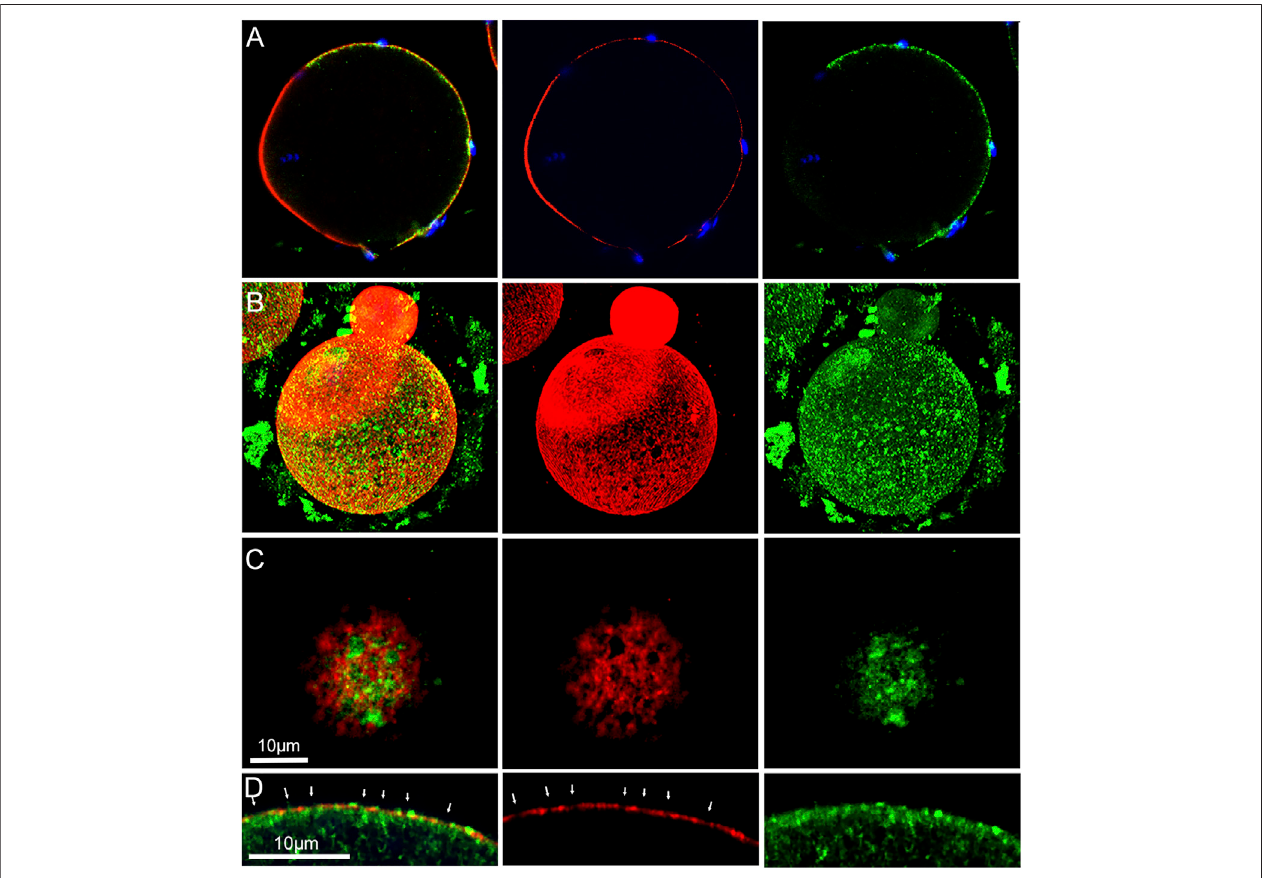
FIGURE 5 | Distribution of f-actin and Rho A in the oocyte cortex.MII oocyte from a virgin female fi xed and labeled with anti- Rho A (green) and Alexa Fluor-568 phalloidin (red) as well as Hoechst 33342 (blue) showing the polarized localization of Rho A (A) . Oocyte from a mated female was treated by prolonged fi xation and labeled as above. Z-stack images viewed in volume mode (B) , or a tangential image reveal the association of fenestrae with Rho A aggregates (C) . An equatorial image revealsthepositionofRhoAaggregatesundersomefenestrae (D) .ArrowsindicatethepositionoffenestraewithunderlyingRhoAaggregatesandoccasionalRho A foci (bright green) overlying f-actin interstitial regions. Images were selected from 12 oocytes recovered from 3 females. Magni fi cation is indicated by the bar.